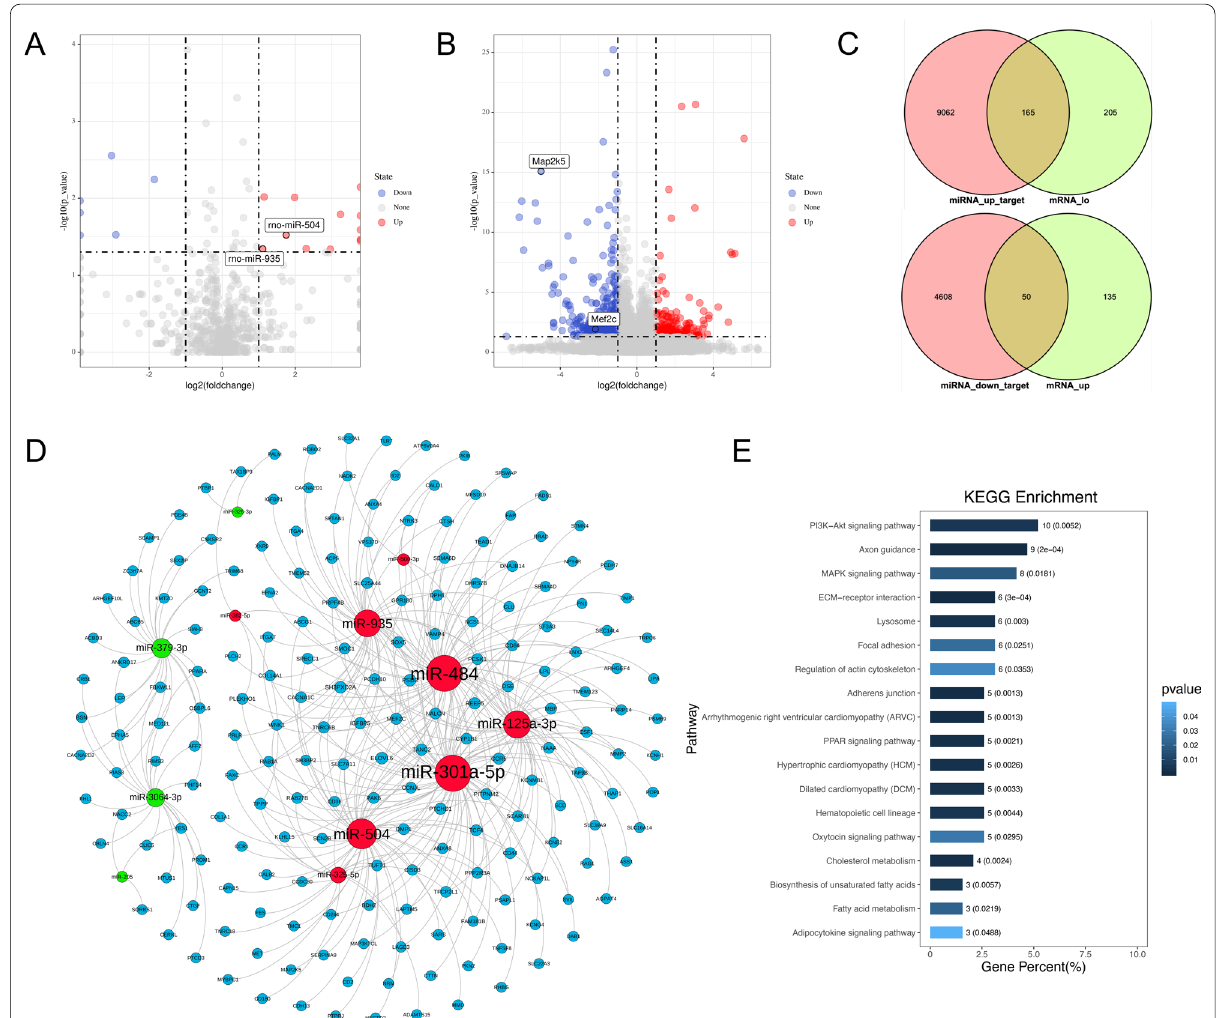
Fig. 2 Bioinformatics analysis of testicular miRNA by RNA sequencing. Volcano plot analysis of differentially-expressed miRNAs ( A ) and mRNAs ( B ) in the diabetic vs. normal testis from ND and DM rats. The log2 transformation of the fold change in the expression of miRNAs and mRNAs between diabetic and normal testes from each group is plotted on the x-axis. The log p-value (base 10) is placed on the y-axis. Differentially-expressed miRNAs and mRNAs (fold change 1) are indicated in red (upregulated miRNAs and mRNA in diabetic testis) and green (downregulated miRNAs ≥ and mRNA in diabetic testis). Upregulated (miRNA_up_target) and downregulated (miRNA_down_target) miRNA-target genes were predicted online using TargetScan (http:// www. targe tscan. org/). The overlapping target genes and downregulated (mRNA_lo) or upregulated (mRNA_up, C ) mRNAs were identified via Venn diagrams. The miRNA–mRNA regulation networks were constructed using the Gephi software ( D ). Red dots represent upregulated miRNAs, whereas green dots indicate downregulated miRNAs, and blue dots indicate downstream target genes. KEGG analysis of upregulated and downregulated mRNAs in the miRNA–mRNA regulation networks ( E